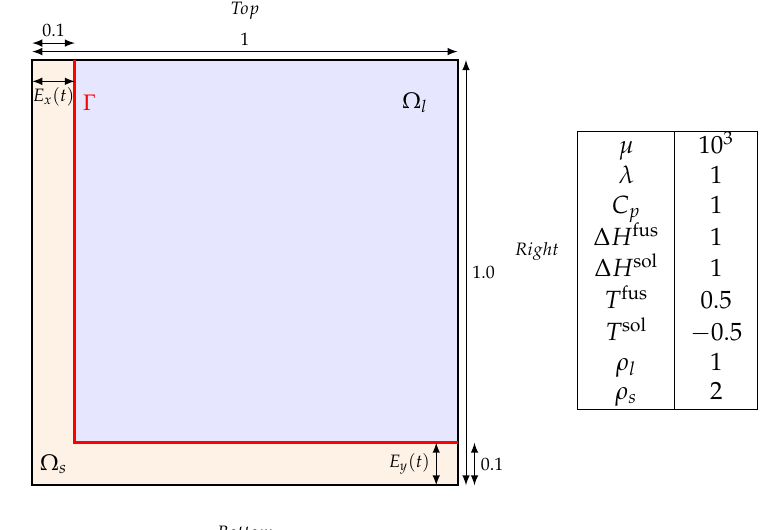
Figure 7. Two-dimensional corner Stefan-like test case—( Left ): Initial configuration where a cold solid generates the solidification of the blue liquid through the red phase change front Γ —( Right ): Physical